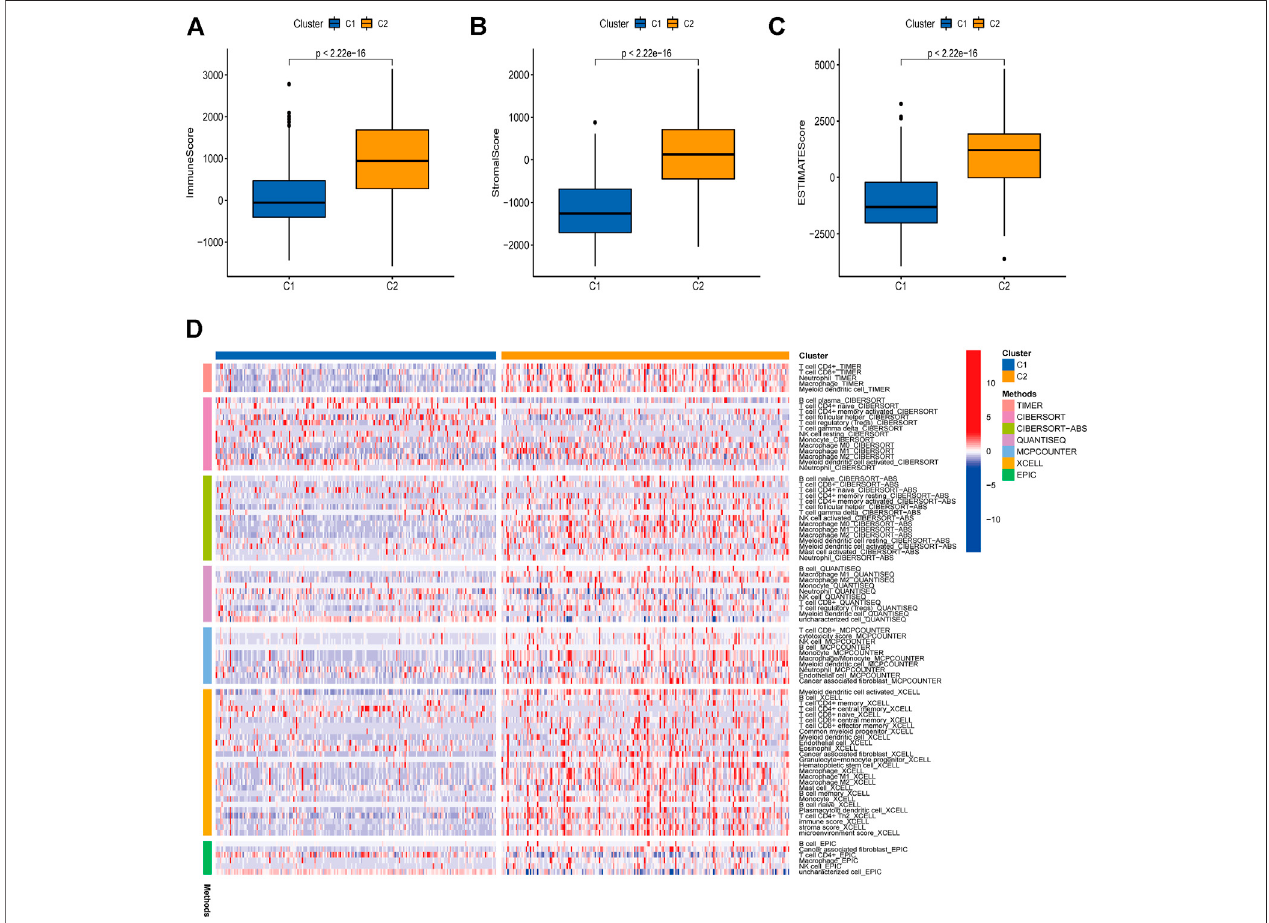
FIGURE 2 | Immune in fi ltration in two subtypes. A correlation was investigated between the Immune and Stromal scores of the two clusters using the ESTIMATE method (A – C) . Immune in fi ltration cells in the two cluster groups were visualized (D) .